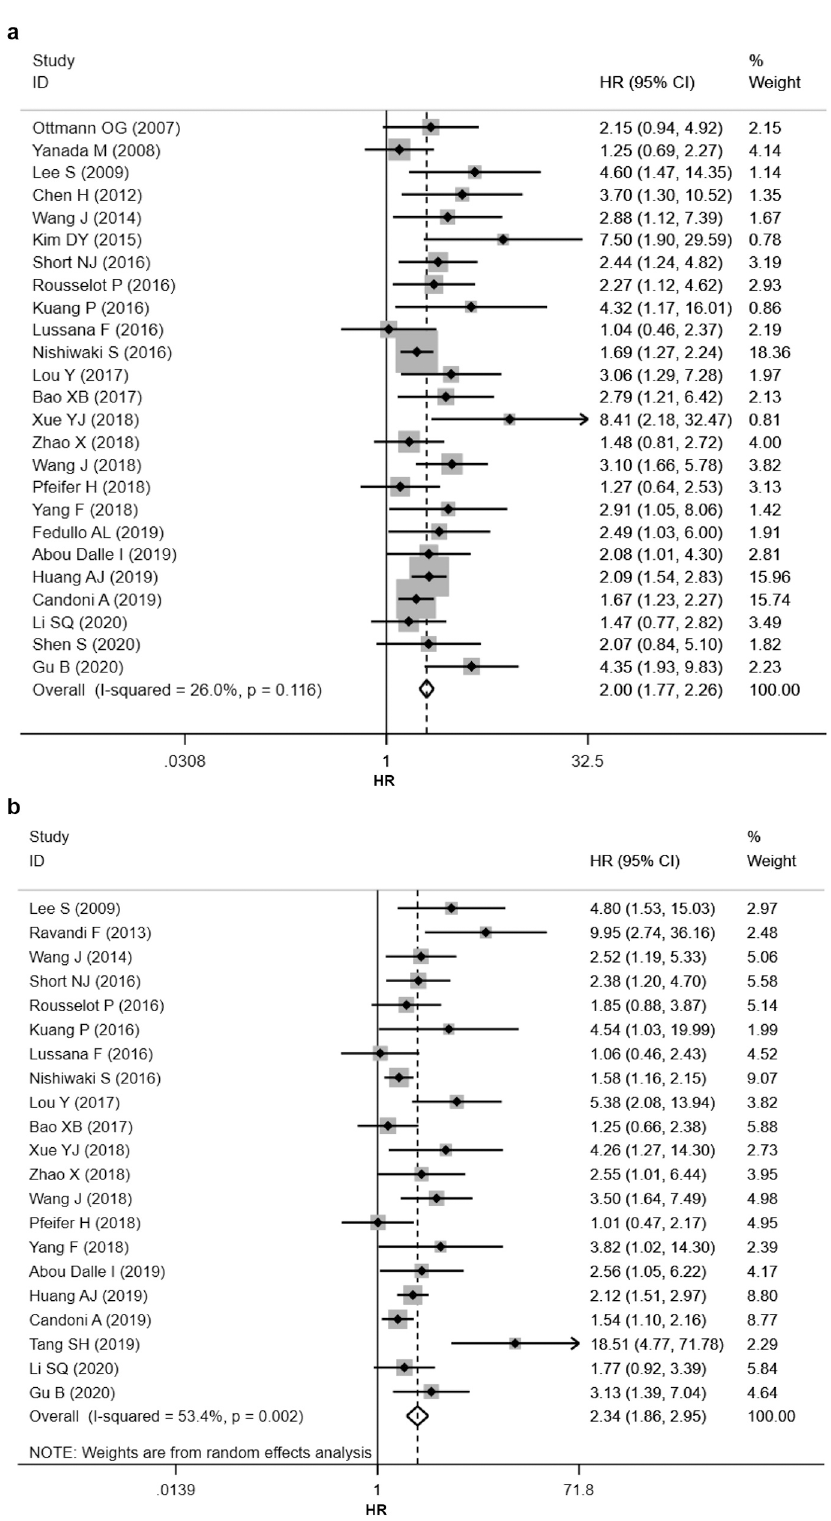
Fig 2. Forest plots for the impact of MRD status on the clinical outcomes of Ph+ ALL patients. (a) Forest plot for event-free survival (EFS). (b) Forest plot for overall survival (OS).